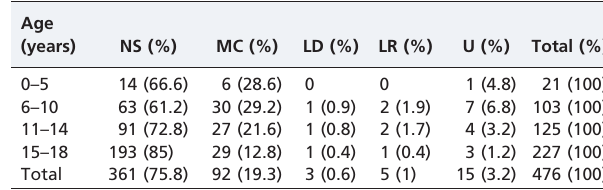
Figure 6 - Classical Hodgkin lymphoma and nodular predomi- nance lymphocyte Hodgkin lymphoma distribution in all age groups.